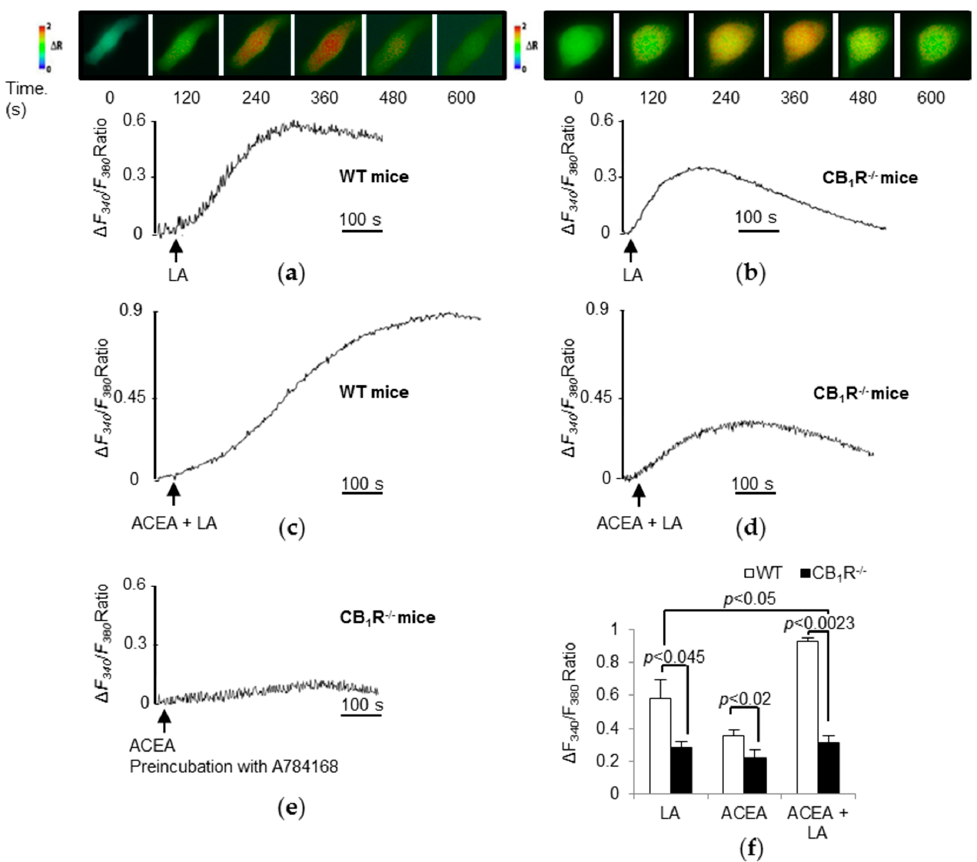
Figure 5. Effects of linoleic acid (LA) and cannabinoids on Ca 2+ signaling in mouse TBC. Ca 2+ imaging studies were performed in calcium-containing (100% Ca 2+ ) buffer. The changes in free intracellular Ca 2+ concentrations ( ∆ F 340 / F 380 ) were monitored under the Nikon microscope (TiU) by using S-fluor 40 × oil immersion objectives. Colored time-lapse changes show the kinetics of the rise in [Ca 2+ ] i levels in taste bud cells freshly isolated from WT mice ( a ) and CB 1 R − / − mice ( b ) following addition of LA (25 μ M) and the corresponding graphs below. Changes in [Ca 2+ ] i evoked by combined addition of ACEA (1.5 µ M) and LA (25 µ M) in WT ( c ) and CB 1 R − / − TBC ( d ), respectively. Changes in [Ca 2+ ] i evoked by ACEA (1.5 µ M) after a 15 min preincubation with A784168, a TRPV1 antagonist, in CB 1 R − / − TBC ( e ). The arrowheads indicate when the test molecules were added. Variations in ∆ F 340 / F 380